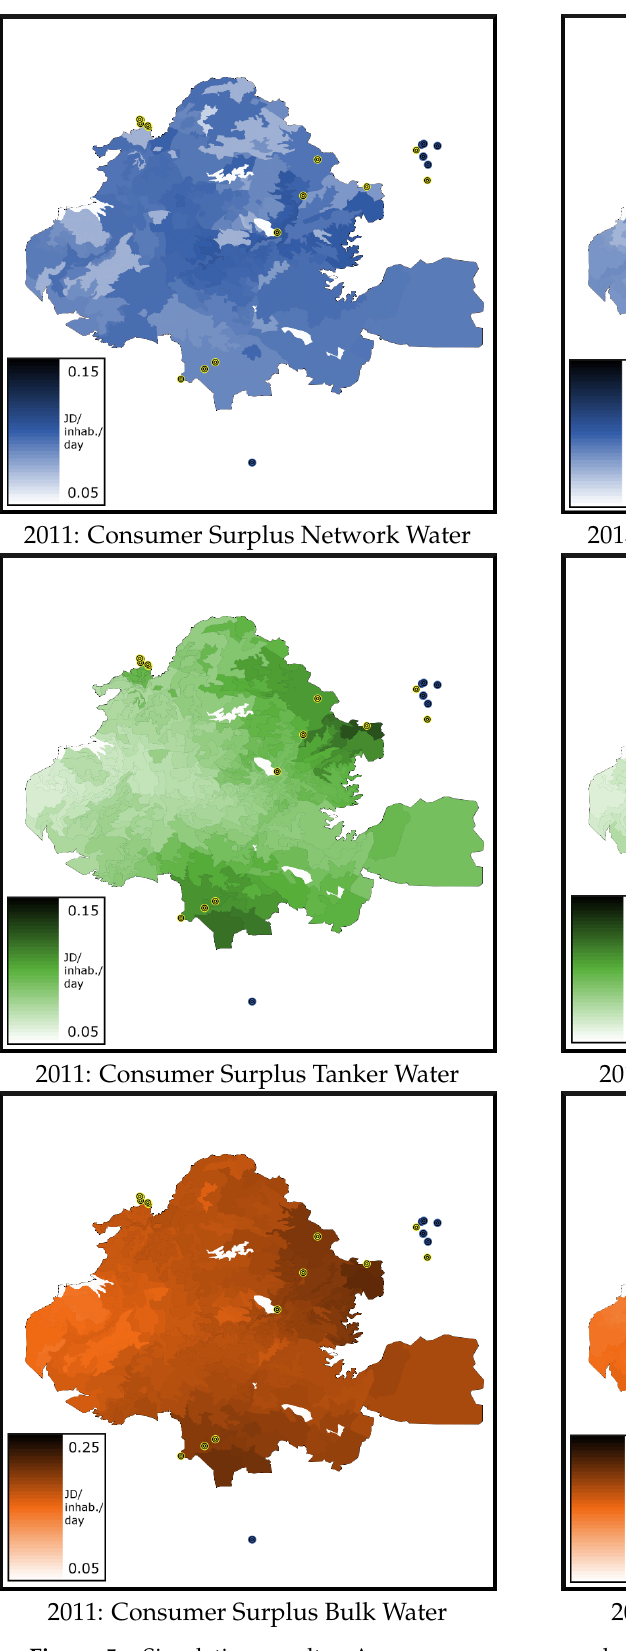
Figure 5. Simulation results: Average consumer surplus per DZ for the years 2011 and 2015, derived from different water